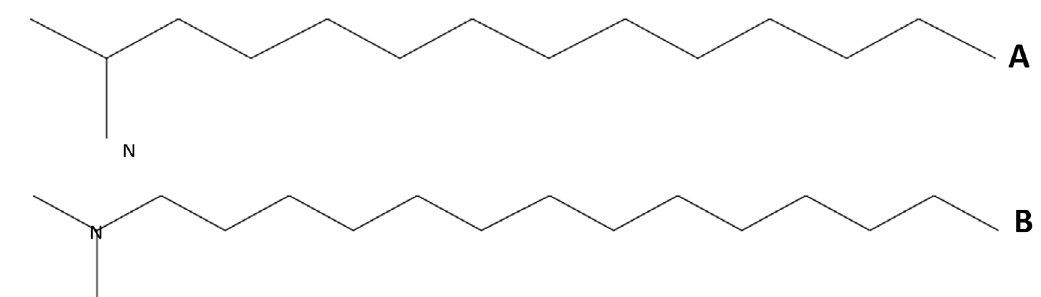
Fig. 11. Mass spectra of Tetradecanamine, N, N-Dimethyl (A) and Methylenebrexane (B).